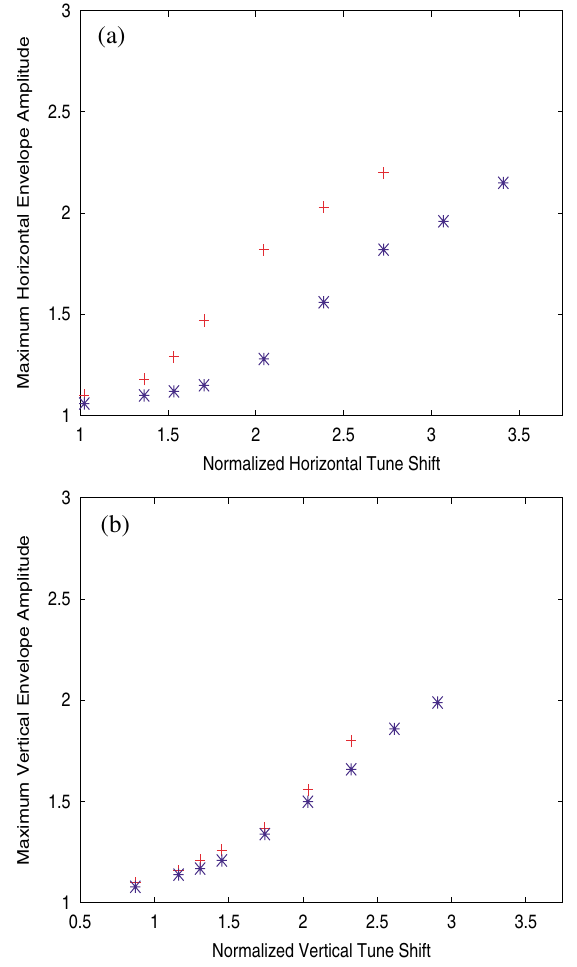
FIG. 5. (Color) Coherent resonance response curves in the horizontal direction (a) and the vertical direction (b) with and without energy spread. The (red) (cid:1) ’s represent the response without dispersion, and the (blue) (cid:13) ’s represent the response with dispersion.